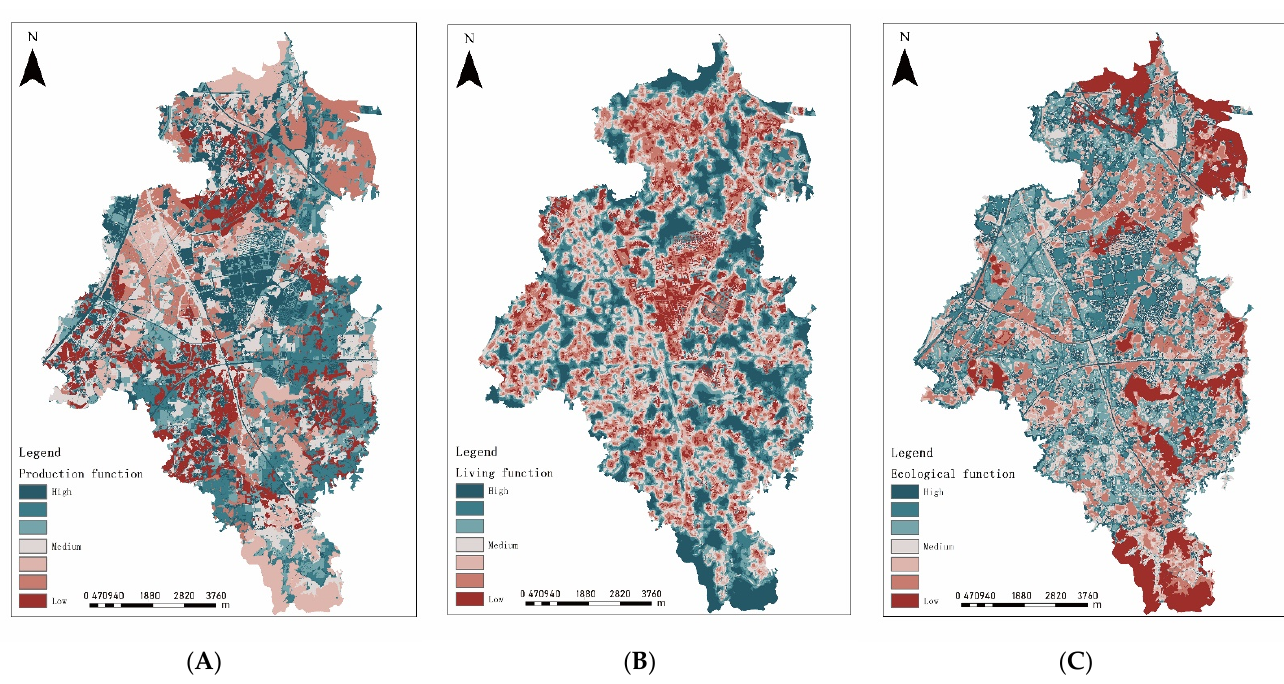
Figure 6. Distribution patterns of the PLE functions. ( A ) Production function; ( B ) Living function; ( C ) Ecological